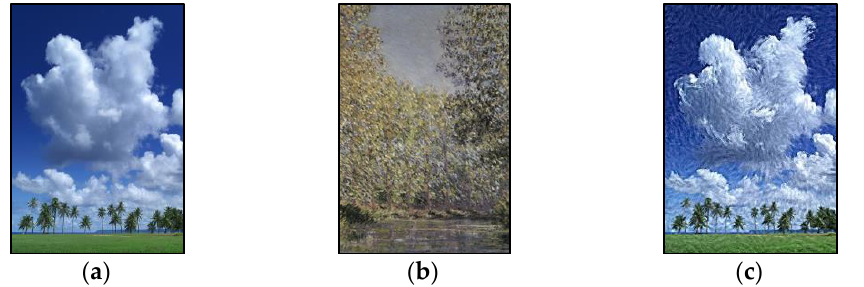
Figure 2. Sample of image rendering: ( a ) Landscape, ( b ) Monet, “Bend in the Epte River near Giverny”, ( c ) Stylized image.